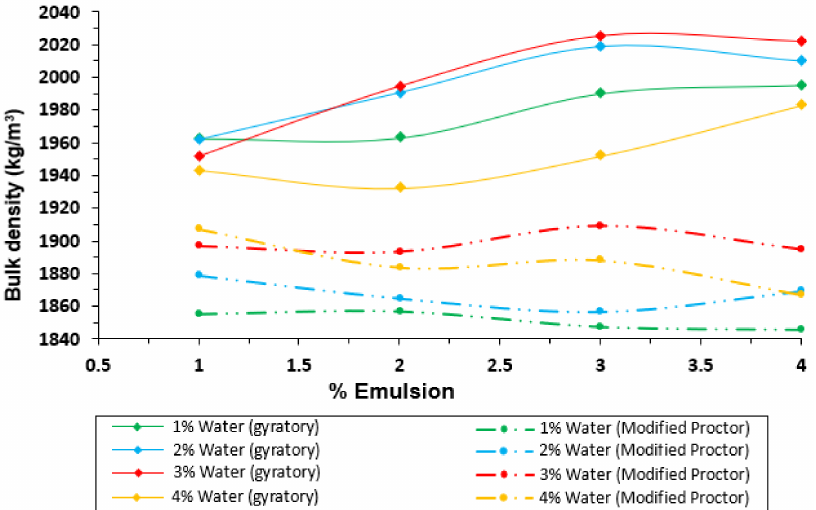
Figure 4. Comparison of bulk density for different premix water contents in samples compacted with the gyratory compactor and the modified Proctor